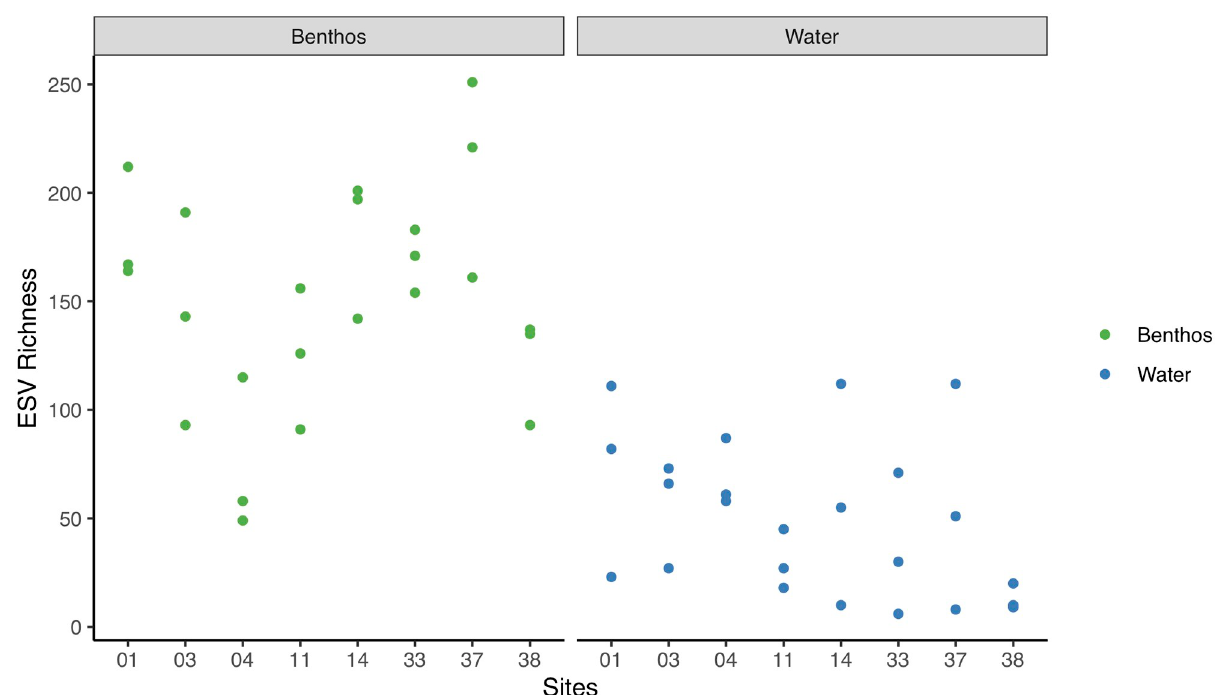
Fig 1. Median arthropod richness per site is higher in benthos samples than water samples. Results are based on normalized data. taxonomically assigned using the COI Classifier v3.2 available from https://github.com/